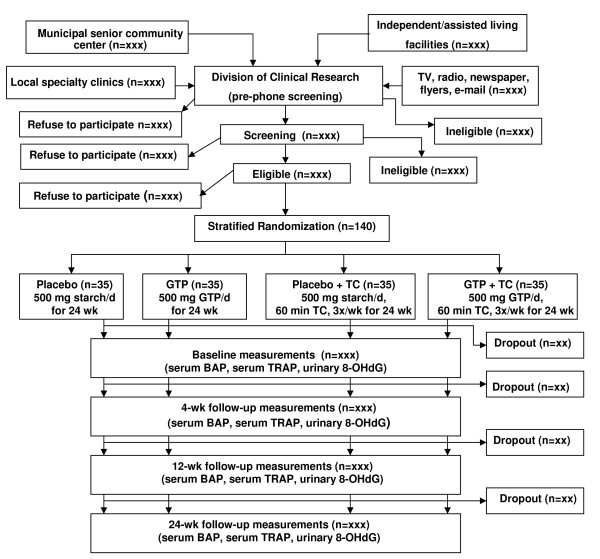
Study flow chart.